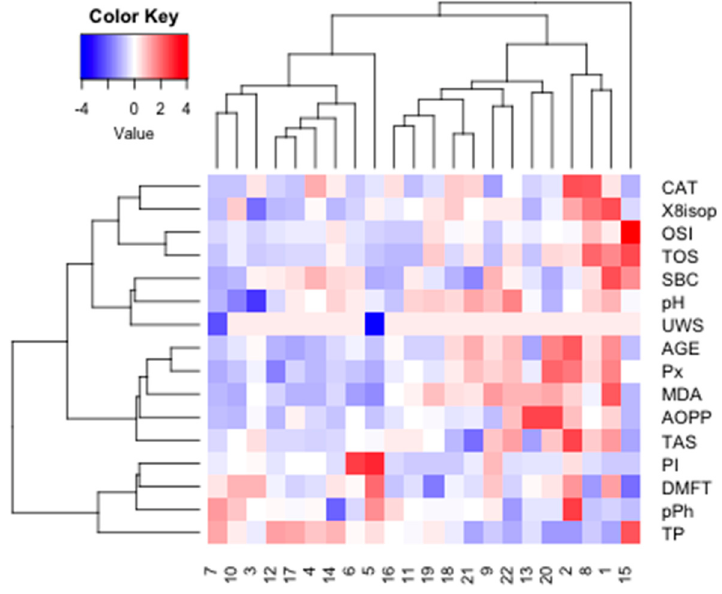
Figure 18. Cluster analysis for group PZ. PZ, generally healthy patients with the BRCA1 mutation; AOPP, advanced oxidation protein products; TP, total protein; OSI, oxidative stress index; TOS, total oxidant status; TAS, total antioxidant status; CAT, catalase activity; pPh, total phenolic content; Pl.I score, Plaque Index; DMFT, decay, missing, filled teeth; UWS, unstimulated whole saliva; SBC, salivary bu ff er capacity; 8-isop, concentration of 8-isoprostane; MDA, concentration of malondialdehyde; AGE, advanced glycation end-products; SBC, bu ff er capacity of saliva; Px, activity of salivary